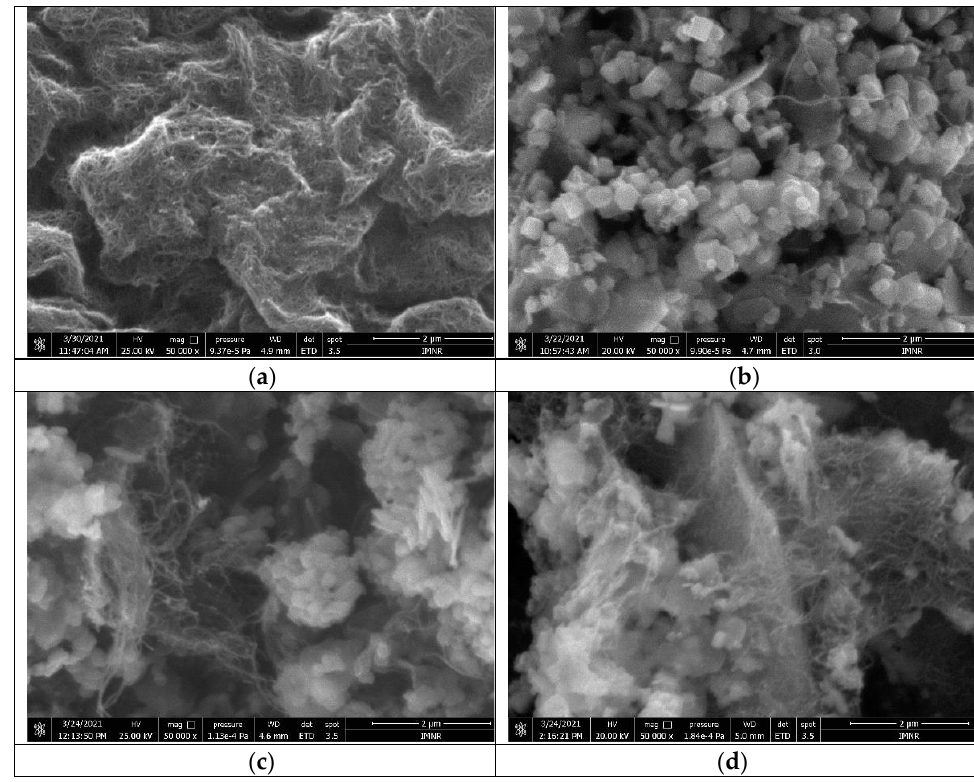
Figure 7. SEM image of: ( a ) CNTFAS -1 sample, 2 µ m scale, 50,000 × magnification; ( b ) CNT-ZnO-2 sample, 2 µ m scale, 50,000 × magnification; ( c ) CNT-ZnO-3 sample, 2 µ m scale, 50,000 × magnification; ( d ) CNT-ZnO-4 sample, 2 µ m scale, 50,000 ×